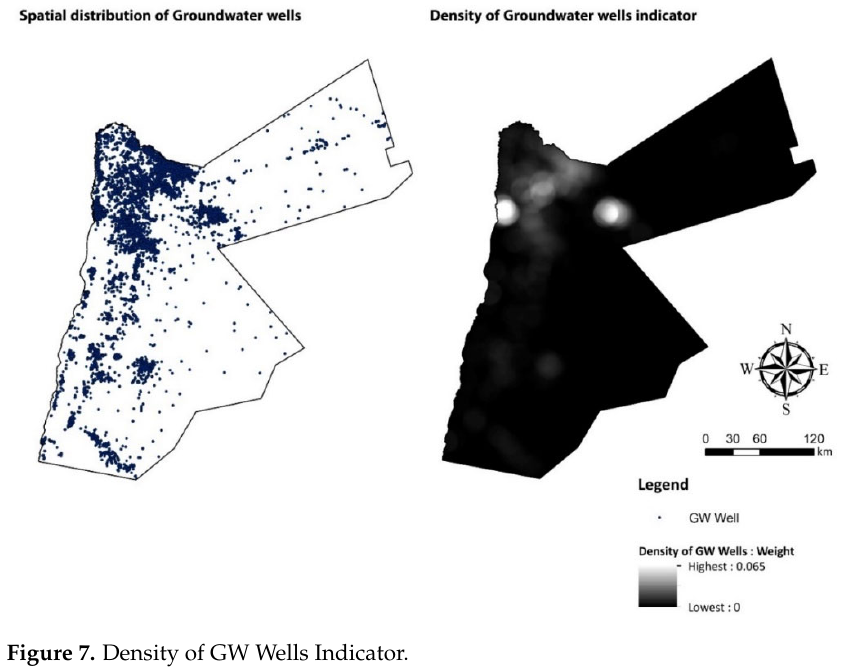
Figure 7. Density of GW Wells Indicator.